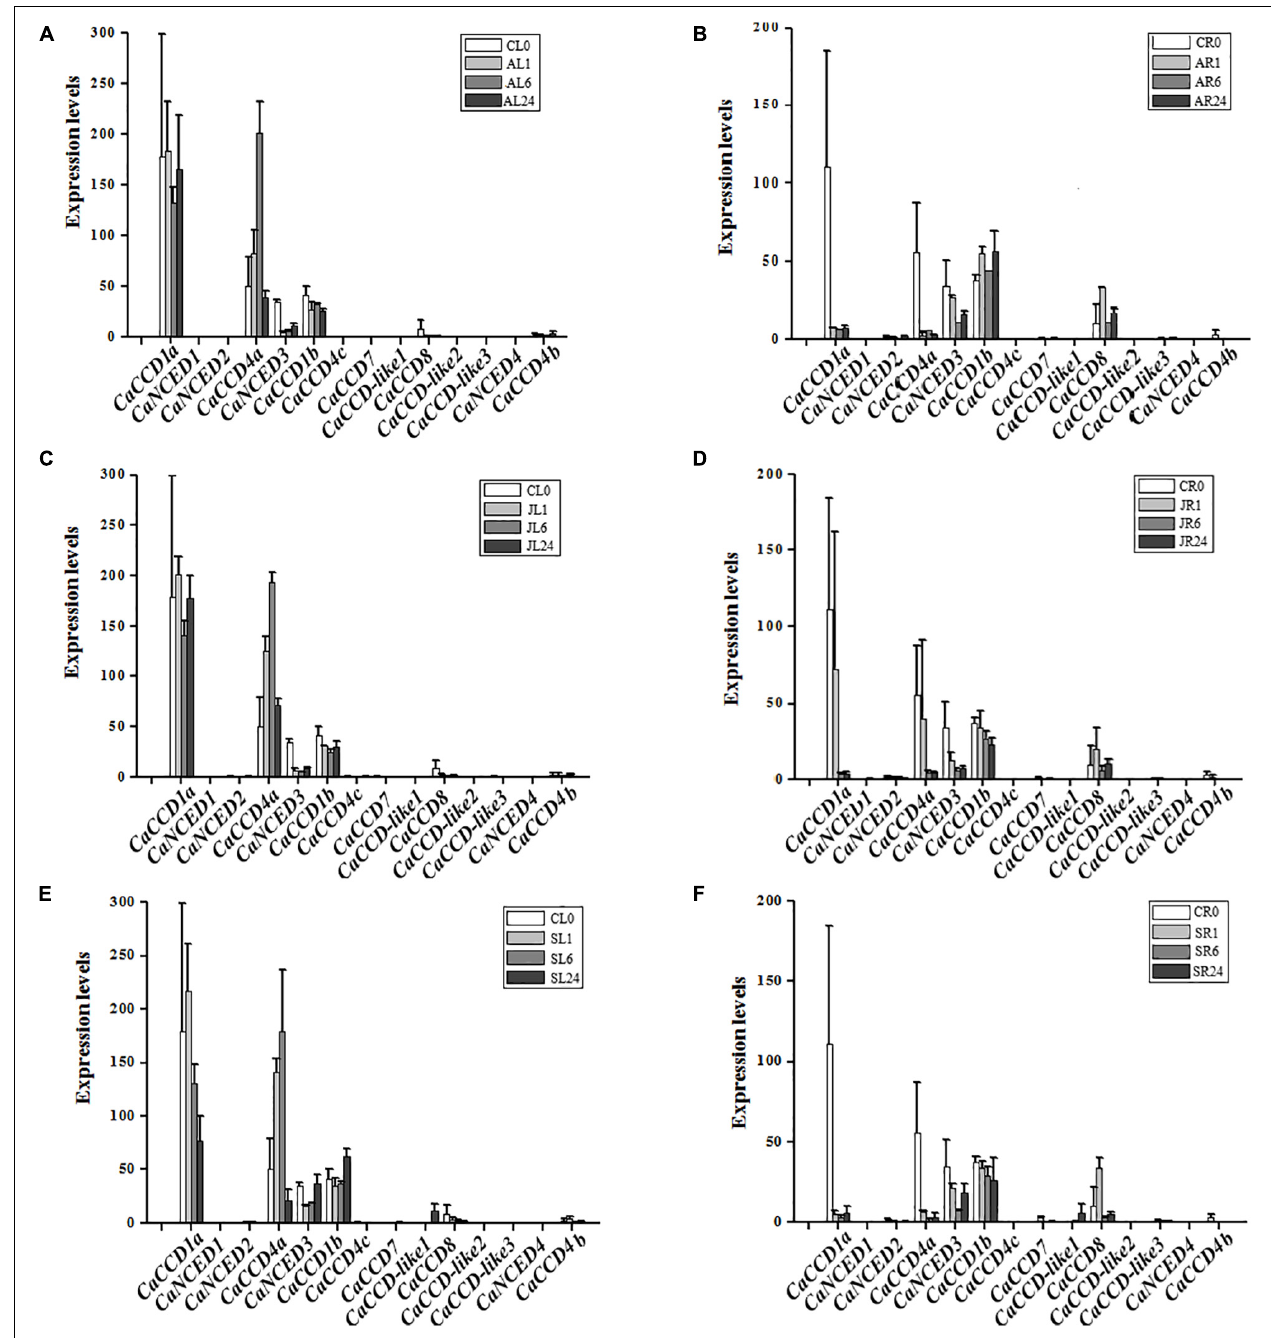
FIGURE 4 | Expression of CaCCO genes under different hormone treatments. (A) Leaves under abscisic acid (ABA) treatment, (B) roots under ABA treatment, (C) leaves under jasmonic acid (MeJA) treatment, (D) roots under MeJA treatment, (E) leaves under salicylic acid (SA) treatment, and (F) roots under SA